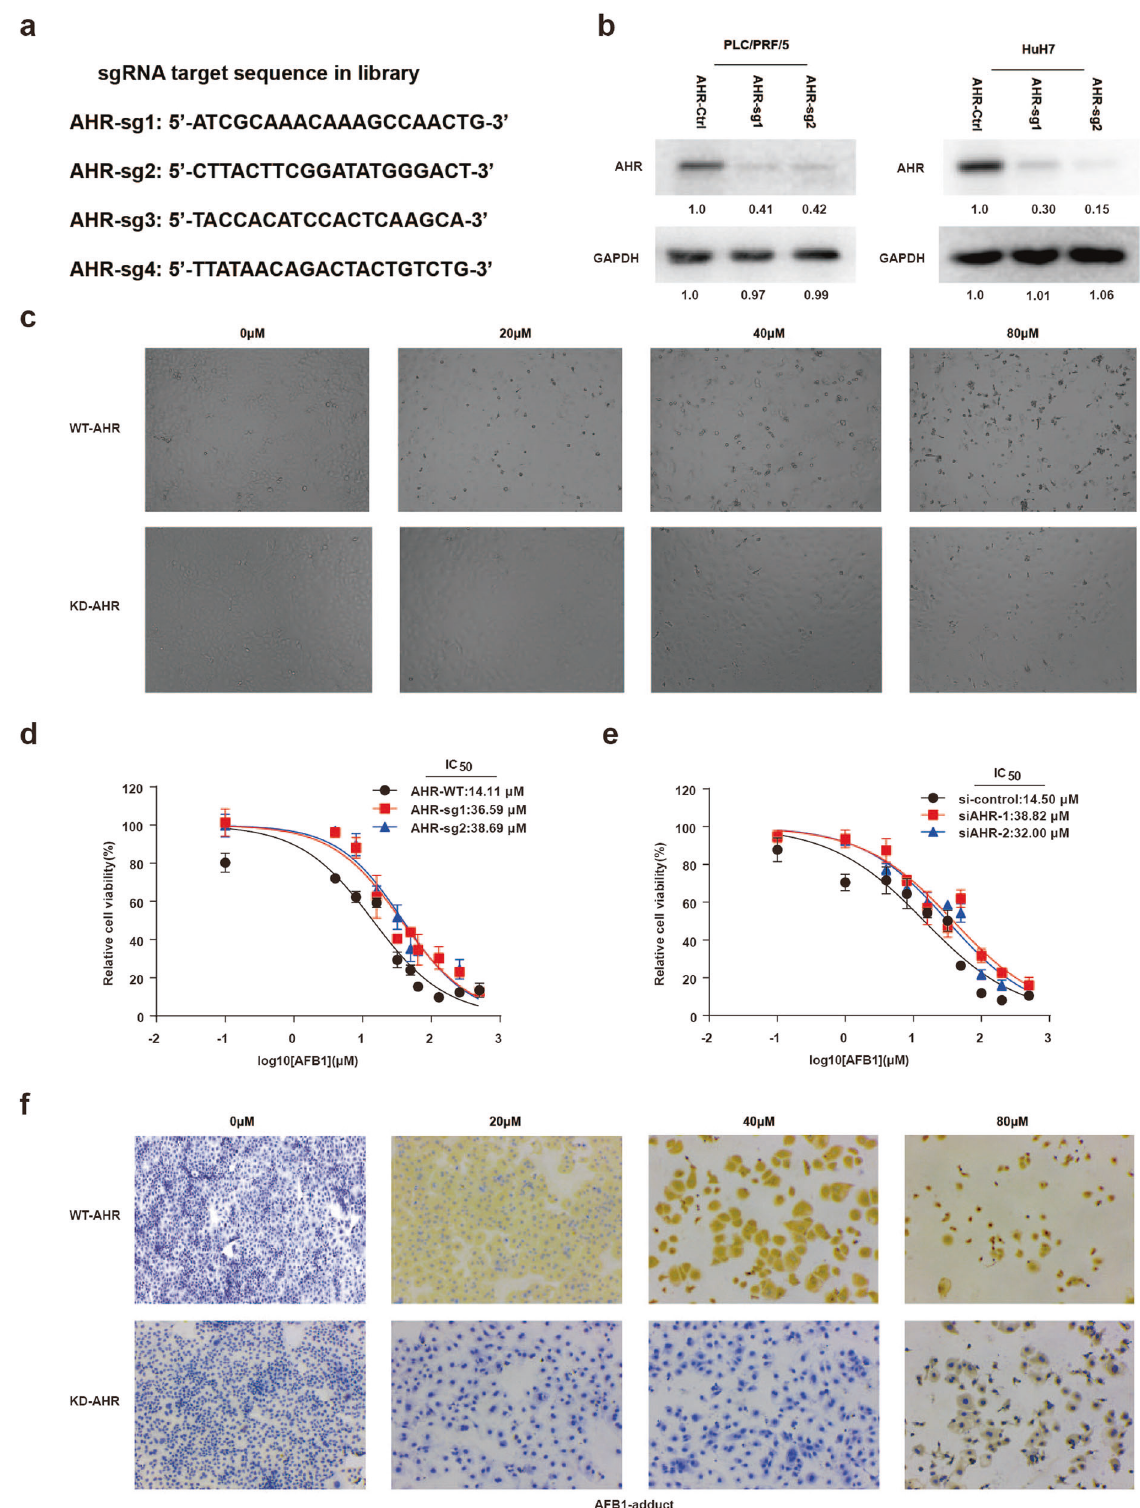
Fig. 2 AHR de fi ciency increases the resistance of liver cancer cells to AFB1 treatment. a AHR sgRNA target sequence in the genome. b Western blot to validate AHR KD in PLC/PRF/5 and HuH7 cells. c Representative images of PLC/PRF/5 cells supplemented in medium containing different concentrations of AFB1 for 48 h. The images were acquired with a LEICA inverted microscope (DMI 4000B). d , e IC50 of AFB1 in AHR WT and AHR KD PLC/PRF/5 cells incubated with AFB1 for 48 h assessed with the CCK8 assay. AHR knockdown was achieved using CRISPR sgRNA technology in ( d ) and siRNA in ( e ). f Immunostaining for AFB1 adducts in AHR WT and AHR KD PLC/PRF/5 cells